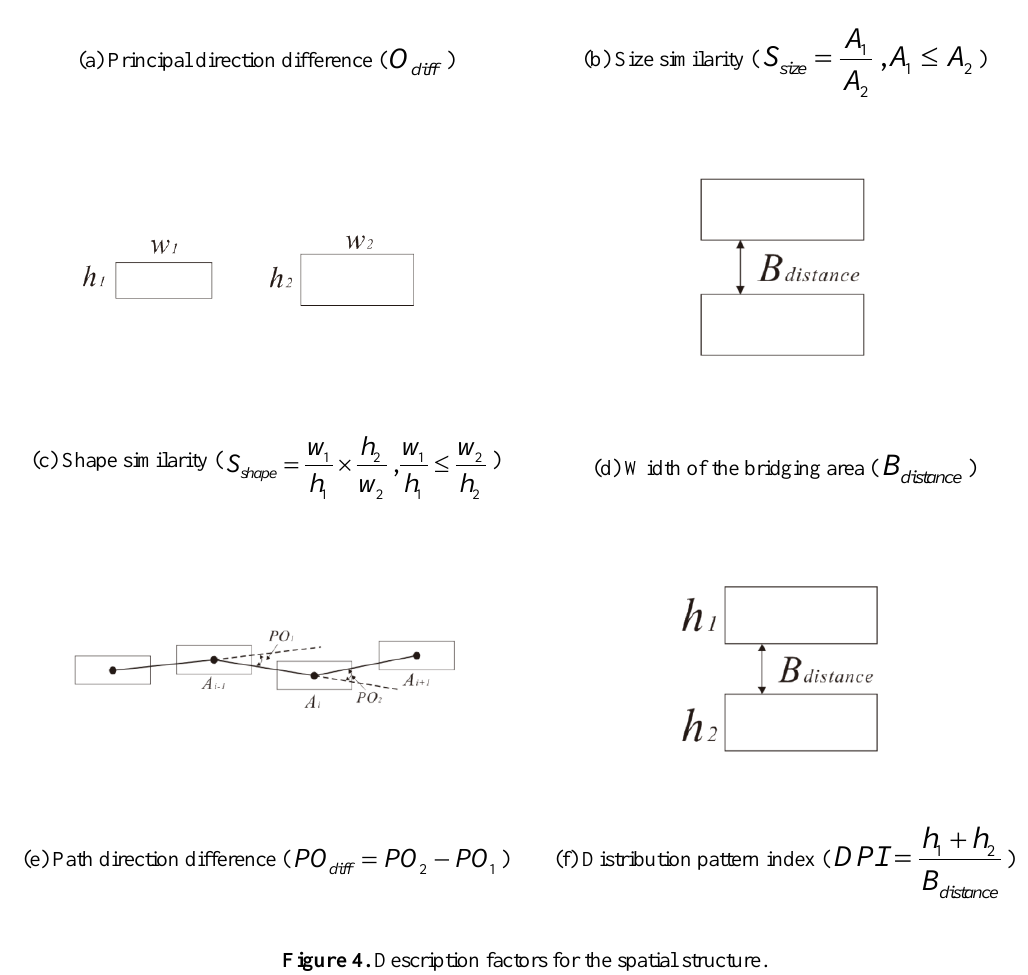
Figure 4. Description factors for the spatial structure.